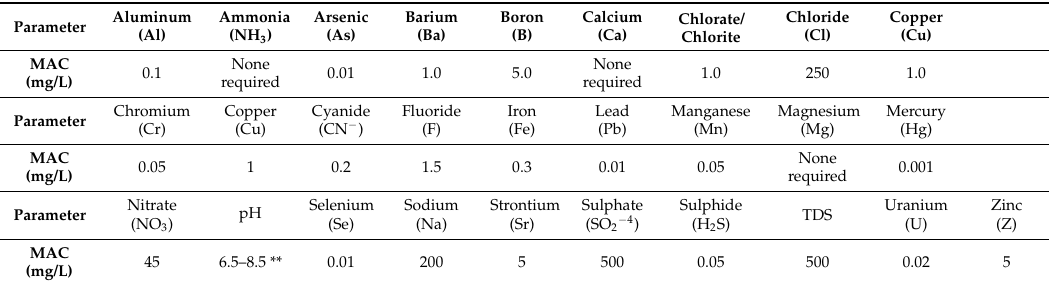
Table 2. Summary of MACs of various chemical and physical parameters reported in Canadian water quality guidelines